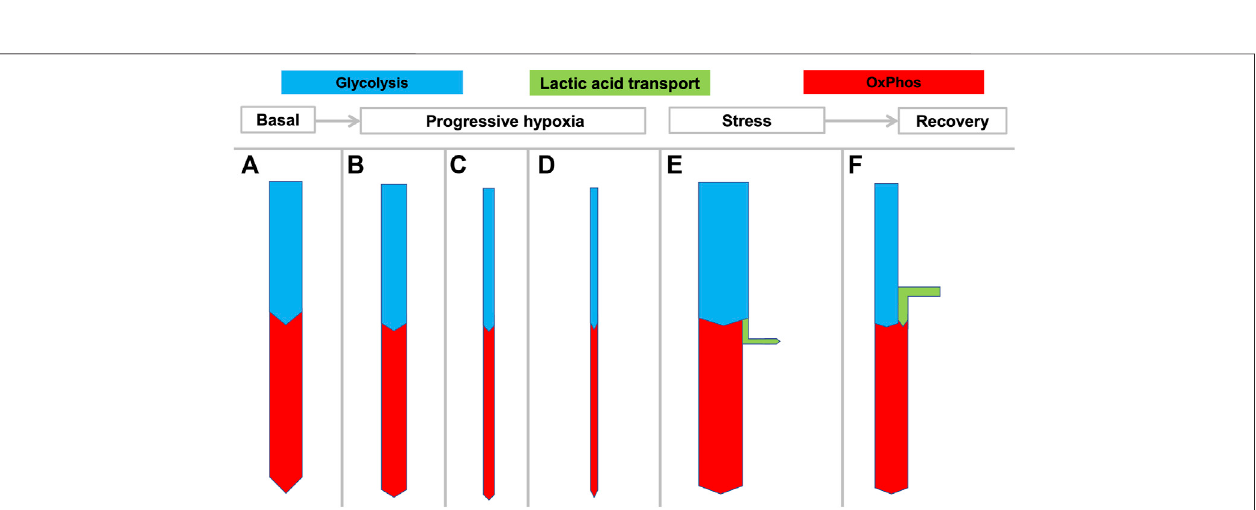
FIGURE 3 | Hypothesized rigid coupling of glycolysis and OxPhos in the NMR with limited lactic acid production. States (A – D) re fl ect the large variation in oxygen consumption seen in NMRs depending on ambient temperature and oxygen availability. During hypoxia the NMR can rapidly and dramatically reduce its metabolic rate andoxygenconsumption,withoutresortingtoanaerobicglycolysiswhichwouldresultinlacticacidosis.At3%O 2 theNMRsdecreased _ VCO 2 and _ VO 2 by80%and87% respectively without developing metabolic acidosis (Pamenter et al., 2019a). State (E) represents the hypothesized limited lactic acid production by the NMR comparedtoothermammalsunderstressconditionssincethismaybeinhibitedbyacidosis.State (F) depictsoxidationofexcesslactateduringrecoverywhensuf fi cient oxygen is